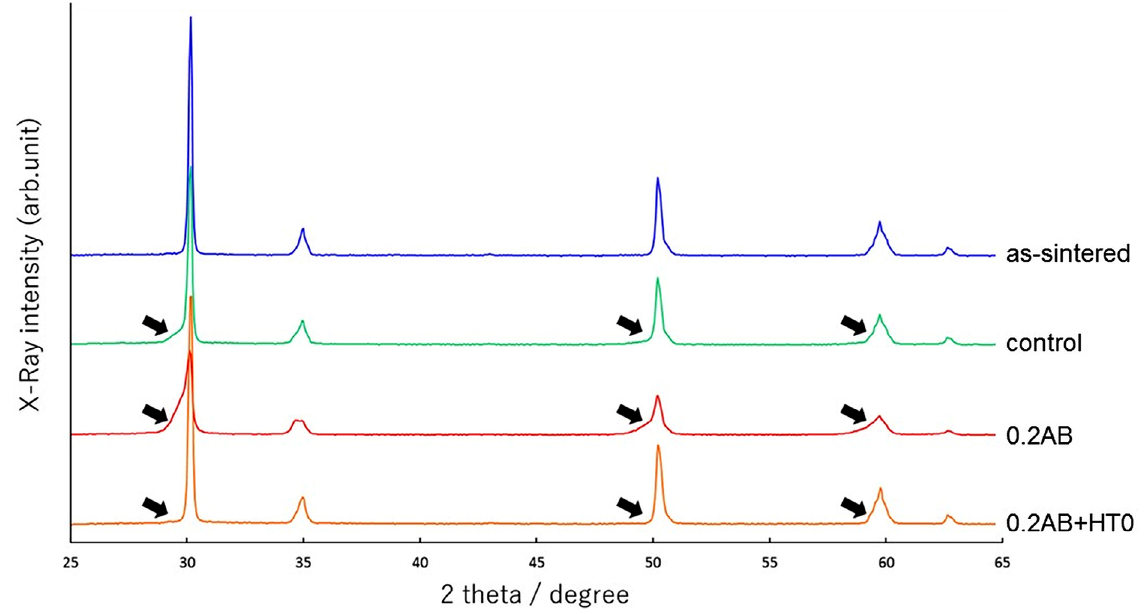
Figure 1- Representative XRD patterns of the as-sintered, control, 0.2AB, and 0.2AB+HT0 groups for the highly translucent Y-PSZ. Three peaks at around 29.7°, 49.5°, and 58.7° 2θ (arrows) implies the presence of r-ZrO2 phase was significantly observed for the 0.2AB group